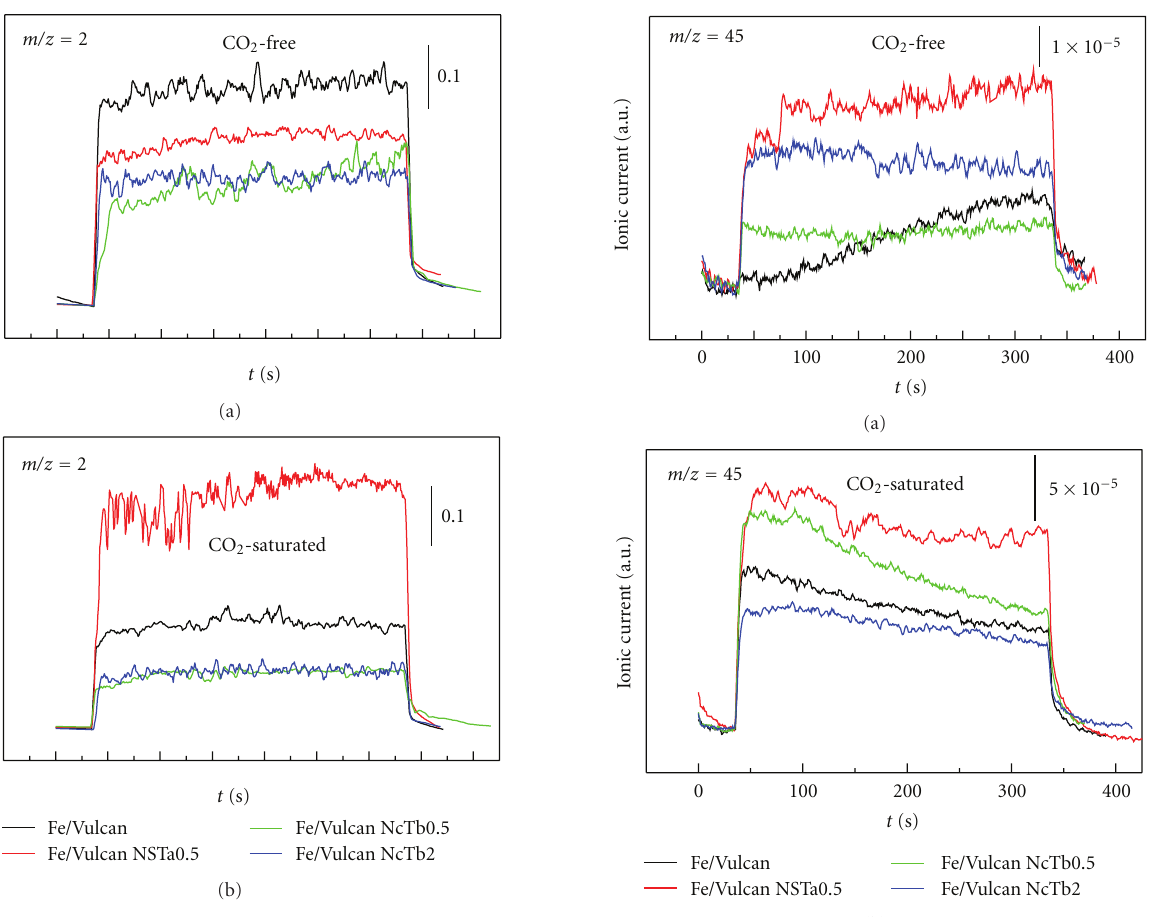
Figure 6: MSTs for CO 2 -free (a) and CO 2 -saturated (b) solution in 0.5 M H 2 SO 4 on Fe/C catalysts ( E i = − 0 . 2 V, E f = − 1 . 8 versus Ag/AgCl/Sat.).